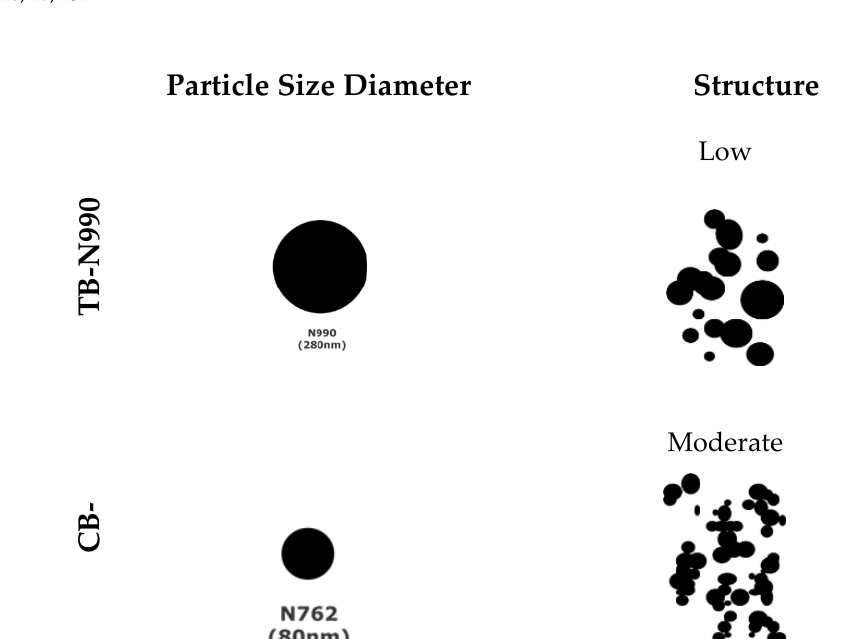
Figure 1. Dimensional and structural differences between Thermax ® N990 thermal black (TB) and Tokai ® N762 furnace carbon black (CB).